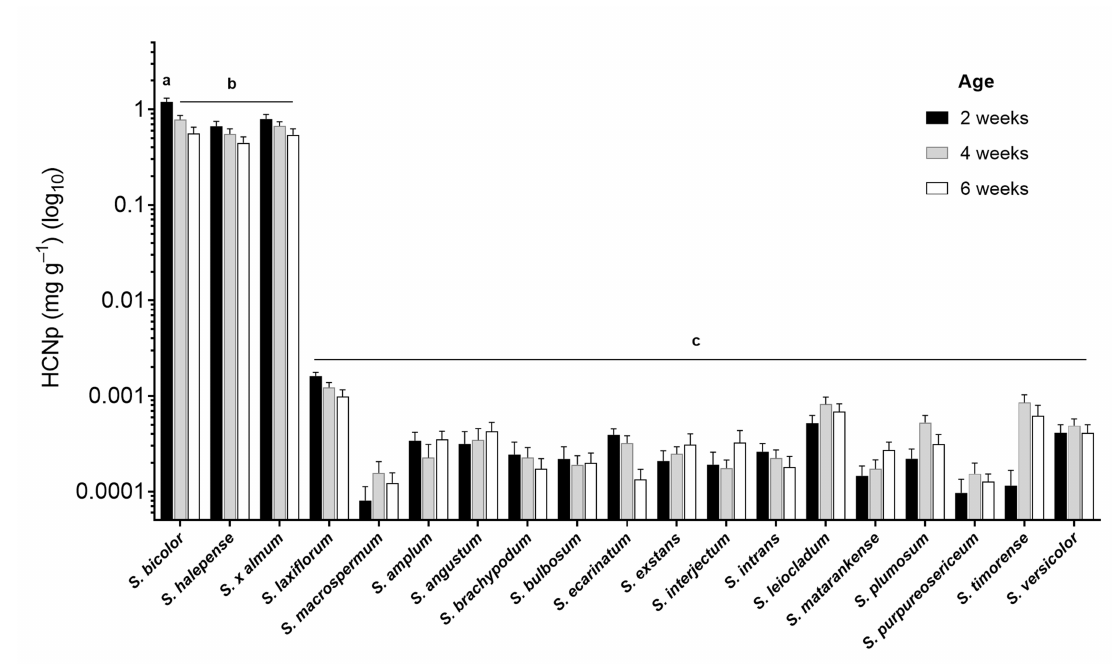
Figure 2. Hydrogen cyanide potential (HCNp) in dried, finely ground leaf tissue of 19 Sorghum species at three time points during plant development plotted on a logarithmic scale. Columns with the same letter superscript are not significantly different ( p <